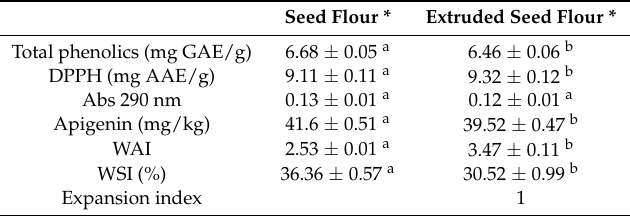
Table 3. Properties of raw and extruded mesquite seed